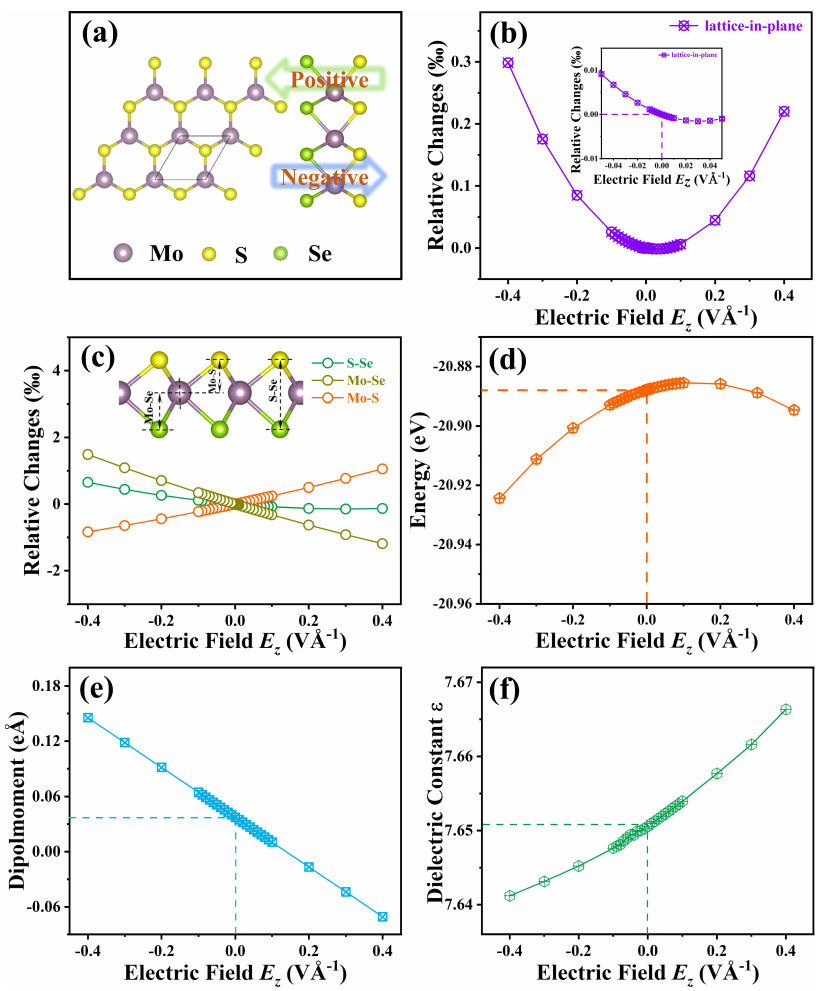
Fig. 1 The effect of electric fi eld on MoSSe. a The top and side views of the con fi guration of 2H MoSSe. The primitive cell is marked by the gray line. The Mo, S, and Se atoms are plotted as the purple, yellow, and green balls. The arrows indicate the directions of the external electric fi elds, where positive refers to the vertical direction from the S to Se atom planes and negative refers to the reversed direction. b The variation of the in-plane lattice constants under the electric fi elds ranging from − 0.4 to 0.4 VÅ − 1 . (Inset) The enlarged view for the electric fi elds ranging from − 0.05 to + 0.05 VÅ − 1 . c The relative distance changes of the S-Se, Mo-Se, and Mo-S atoms planes. The d energy, e dipole moment, and f dielectric constant as a function of the external electric fi